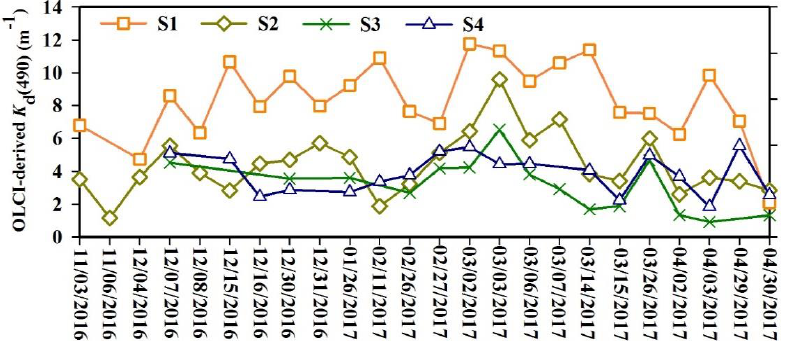
Figure 7. Temporal variations of the OLCI-derived K d (490) at four virtual stations in different lake segments from November 2016 to April 2017. Note that the data influenced by algal blooms and cloud are excluded.